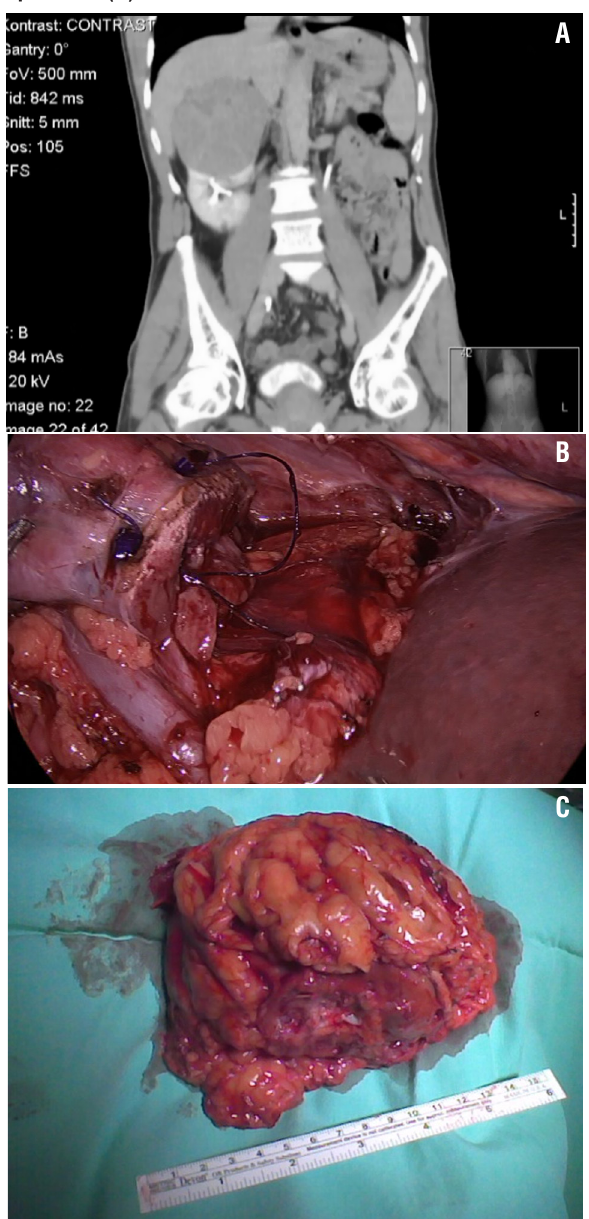
Figure 2 - 10cm right renal tumor. Preoperative imaging (A), intraoperative view of heminephrectomy crater (B) and specimen